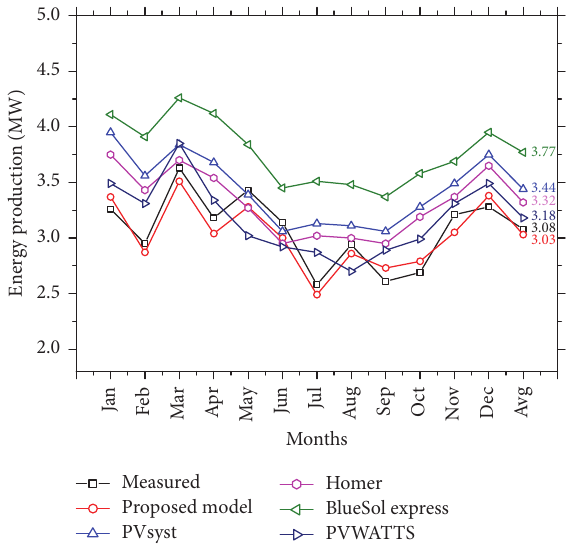
Figure 10: Simulated and measured monthly PV power